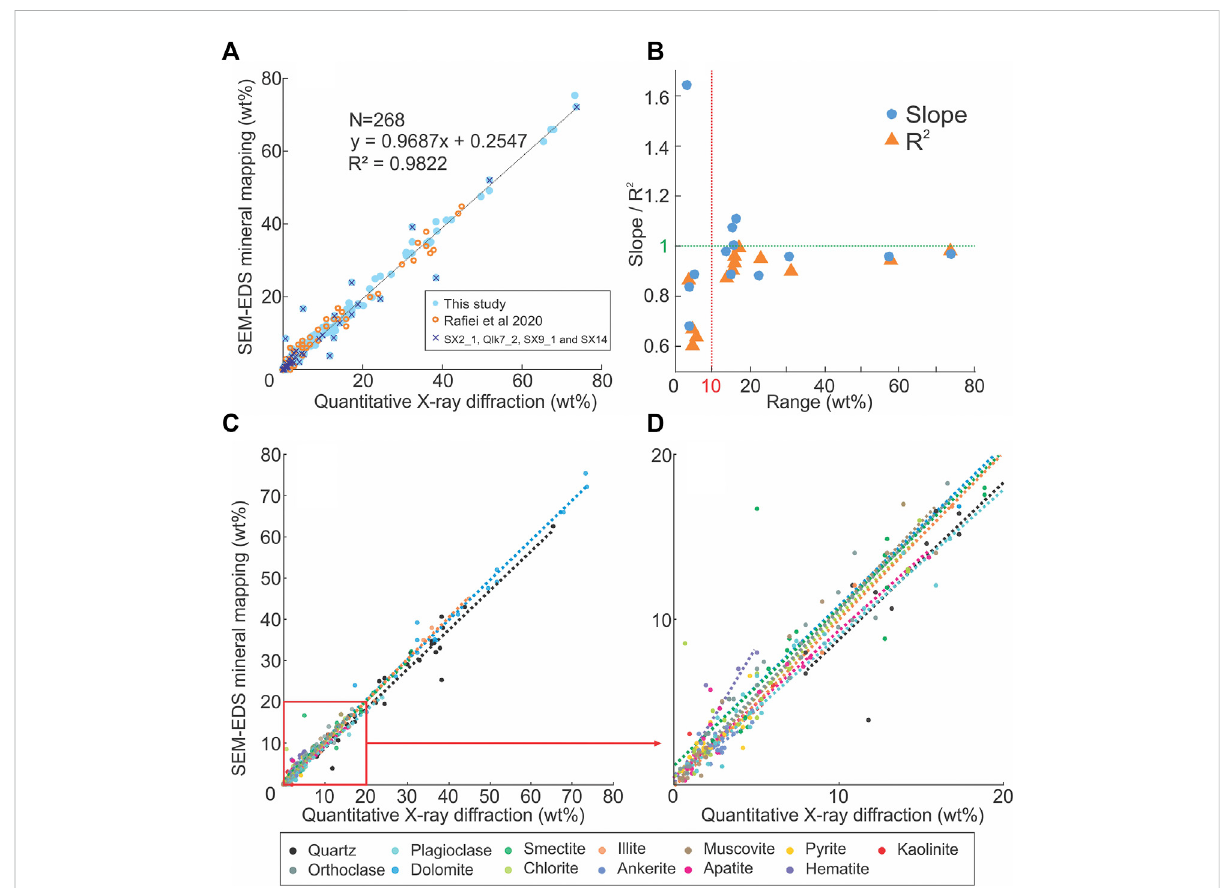
FIGURE 3 Correlation between mineral abundance independently determined by quantitative XRD versus SEM-EDS mineral mapping. (A) , Cross plot of XRD mineralogy ( x -axis) and SEM-EDS mineral mapping mineralogy ( y -axis). Blue points represent data from this study. Dark blue crosses represent datapointsfromfour ROI(SX2_1, Qlk7_2, SX9_1,SX14 — seeSection 4.1).Empty orange pointsrepresentdata fromRa fi eietal.(2020). (B) ,Crossplot of mineral abundance range (max-min; x -axis) versus slope and R 2 values ( y axis). Blue fi lled circles represent slope values and orange fi lled triangles represent R 2 values. Minerals with ranges > 10 wt% show a consistently stronger correlation between mineral abundances obtained from SEM-EDS mineral mapping and XRD analysis. (C) , Cross plot of XRD mineralogy ( x -axis) and SEM-EDS mineral mapping mineralogy ( y -axis) for individual mineral types. Strong correlation overall is evident, but minerals present at less than 10 wt% across all samples show weaker correlations between XRD and SEM-EDS mineral mapping. (D) , zoomed in plot of panel (C) from 0 to